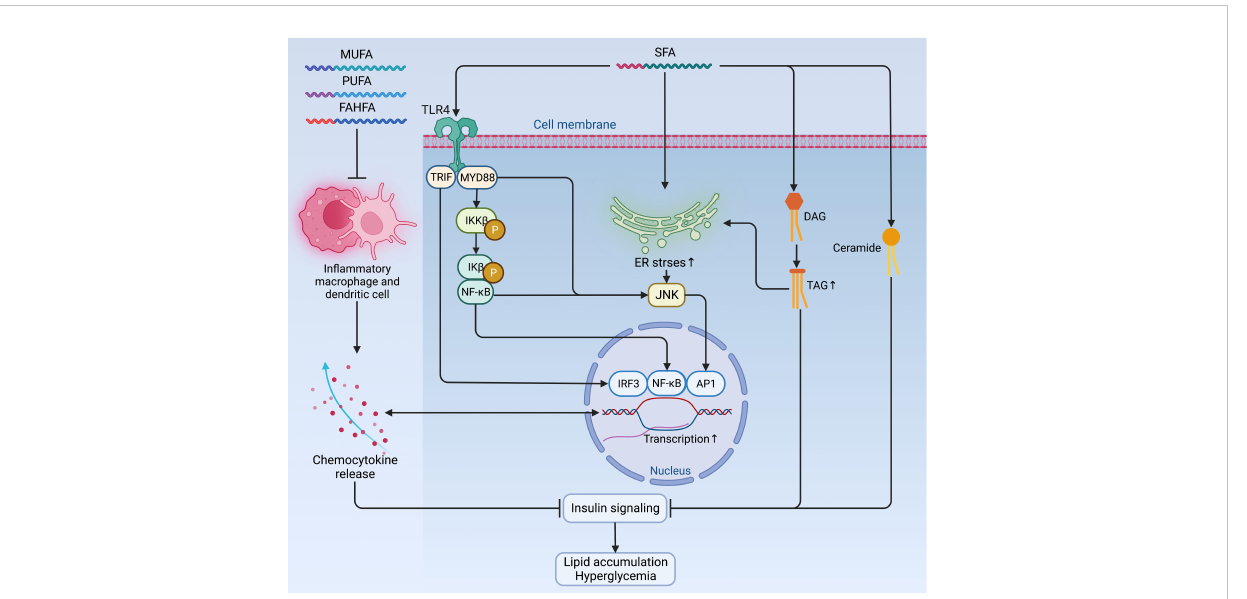
FIGURE 3 Mechanisms of fatty acids affecting insulin signaling and fueling hyperglycemia. Contradictory to the anti-in fl ammatory and insulin-sensitizing effect of PUFAs, MUFAs, and FAHFAs, SFAs sabotage insulin sensitivity by promoting pro-in fl ammatory signaling via TLR4 and its adaptor proteins TRIP and MYD88, which jointly enhance the activity of pro-in fl ammatory pathway and transcription factors, such as IRF3, NF- k B, and AP1 to augment the expression of chemocytokines. Mutually, these pro-in fl ammatory chemocytokines can also activate these pro-in fl ammatory transcription factors as a positive feedback loop to maintain an in fl ammatory environment detrimental to insulin signaling. Meanwhile, the accumulation of TAG, ceramides, and increased ER stress due to activated NF- k B signaling and in fl ammatory cascade can also exacerbate insulin resistance and fuel hyperglycemia. AP1, activator protein 1; ER, endoplasmic reticulum; FAHFA, branched fatty acid esters of hydroxy fatty acid; IKK b , inhibitor of nuclear factor- k B (NF- k B) kinase subunit- b ; Ik b , inhibitor of NF- k B subunit- b ; IRF3, interferon regulatory factor 3; JNK, Jun N-terminal kinase; MUFA, monounsaturated fatty acid; MYD88, myeloid differentiation primary response protein MYD88; NF- k B, nuclear factor- k B; P, phosphorylation; PUFA, polyunsaturated fatty acid; SFA, saturated fatty acid; TAG, triglyceride; TLR4, Toll-like receptor 4; TRIF, TIR-domain-containing adaptor-inducing interferon- b